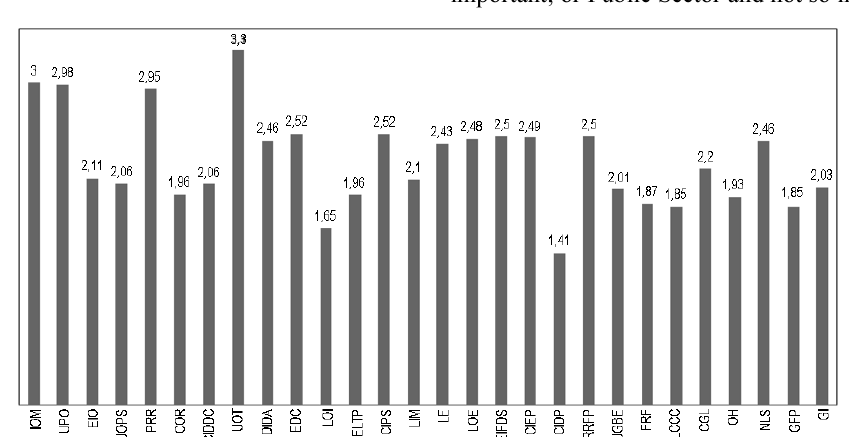
Fig. 6. Risk index value for the Sulaibiya Wastewater Treatment Plant project in